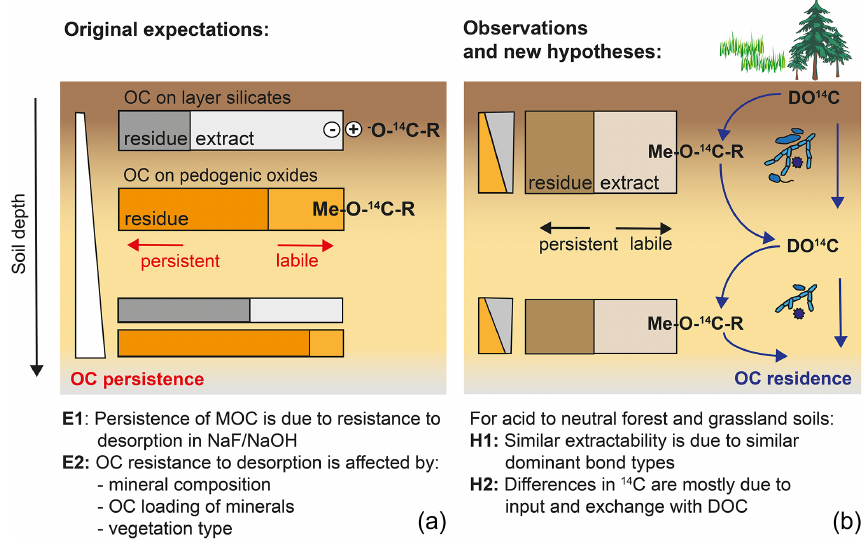
Figure 9. Graphical summary of (a) original expectations where potential MOC desorption explains MOC persistence and varies with mineral composition and soil depth, and (b) the observation of site-independent desorption and alternative hypotheses explaining variations in (cid:49) 14 C values of MOC across sites and with